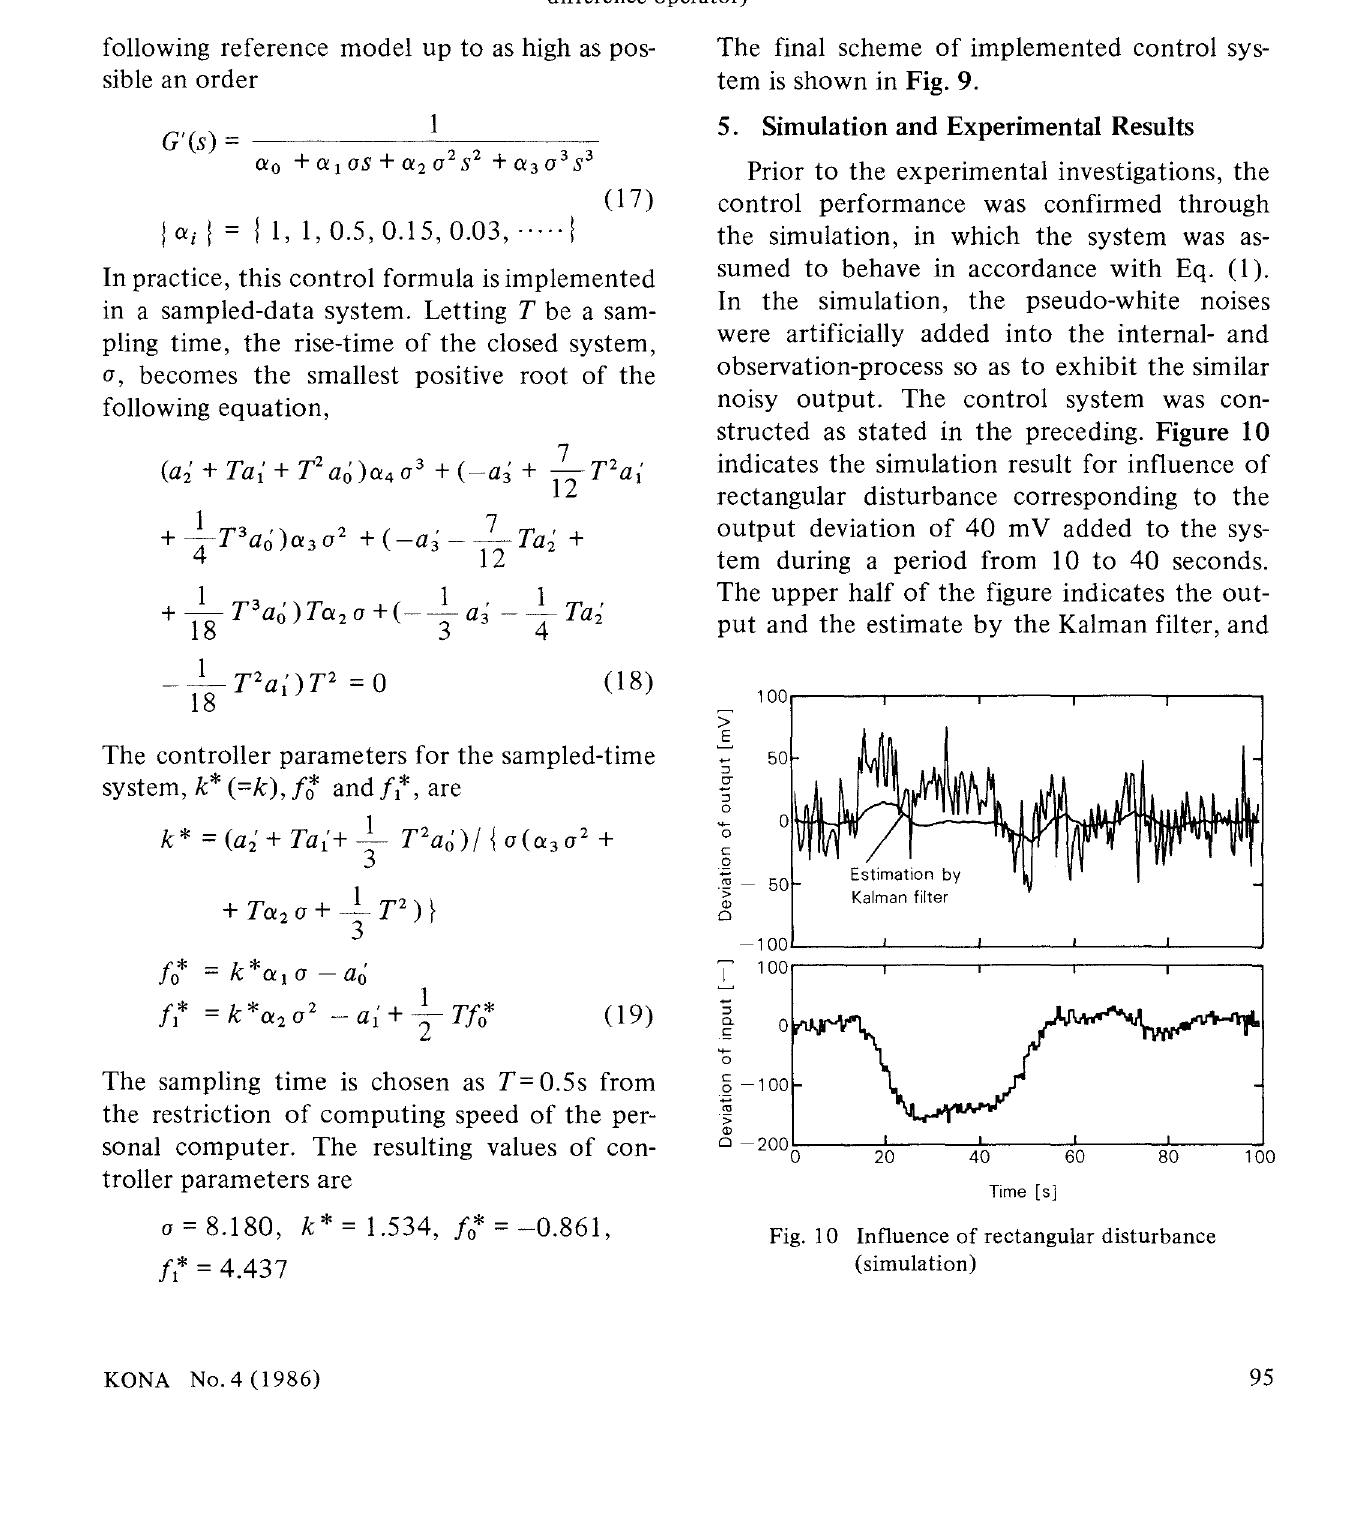
Fig. 9 Scheme of control system (Ll= (1 - z- 1 )/T; difference operator)